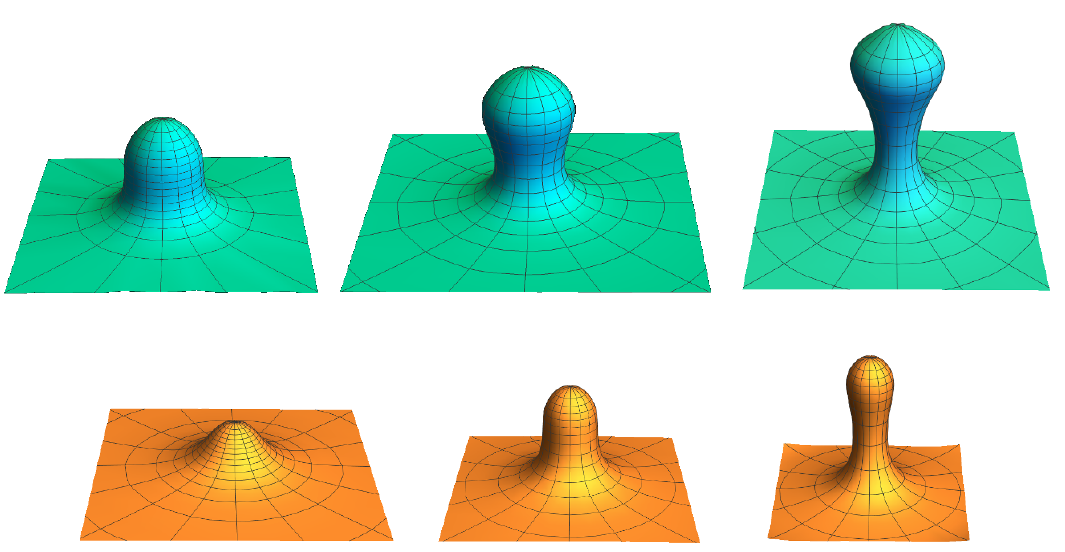
Figure 8 . The embeddings of the boundary geometry in hyperbolic space are shown in light blue in the upper panel. The corresponding horizon geometry is shown in yellow. In the plots, (cid:22) = 3 : 8 and the values of (cid:23) , from left to right are (cid:23) = 2 : 1, (cid:23) = 3 : 65, (cid:23) = 3 : 83. (cid:15) The scalar curvature at the tip of the globule is always larger on the horizon than on the